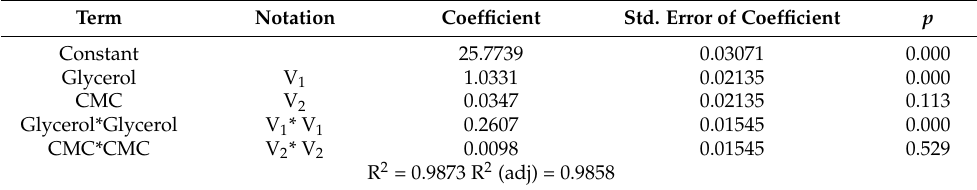
Table 5. Estimated effects and coefficient for glycerol and CMC on the color lightness. Term